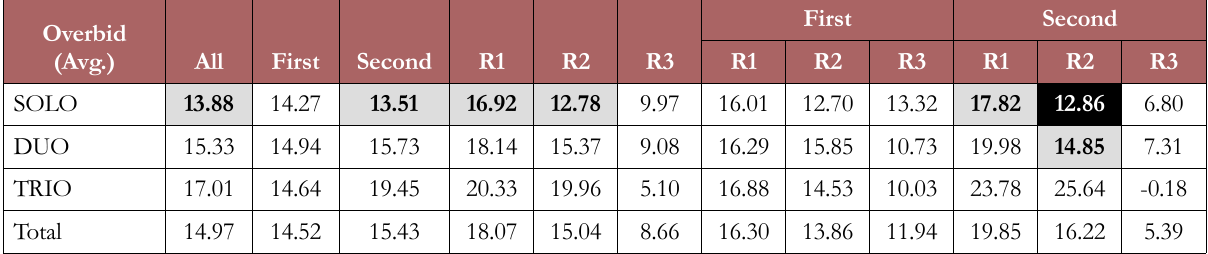
Table 5. Overbid: pairwise differences in terms of size by right and mechanism